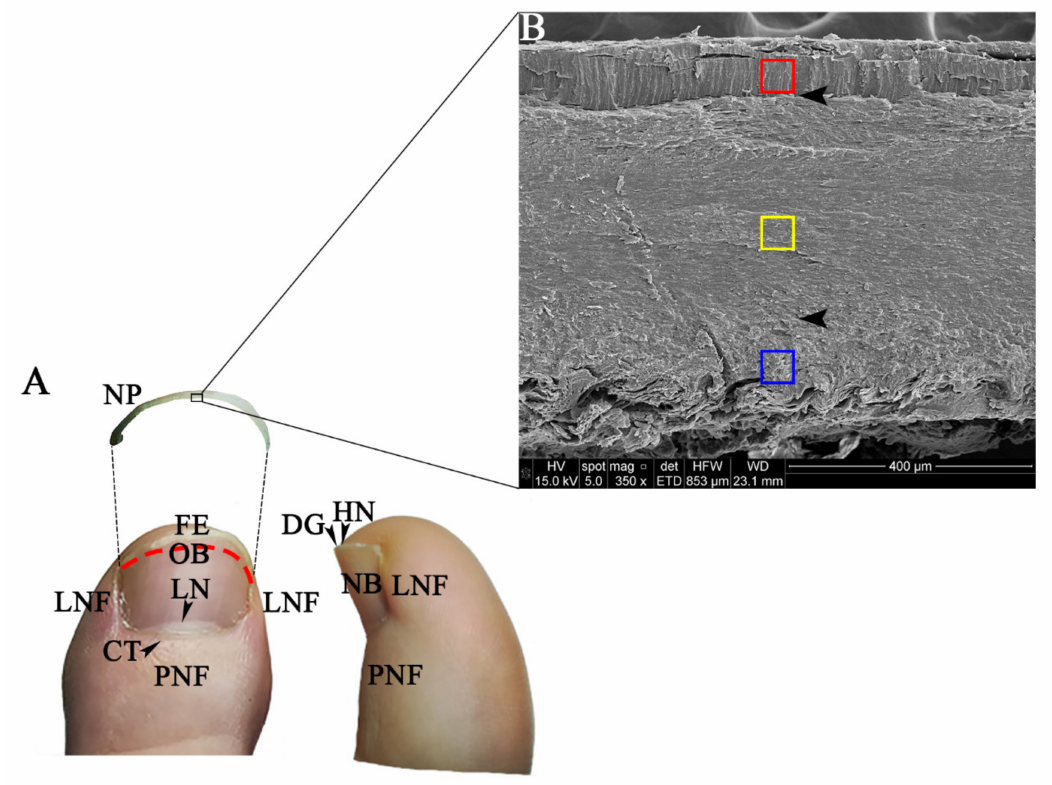
Figure 1. Nail apparatus and measuring areas in the nail plate. ( A ) Dorsal and medial view of the first toe of the left foot and elements of the nail apparatus identifiable to the naked eye. CT, cuticle; DG, distal groove; FE, free edge; HN, hyponychium; LN, lunula; LNF, lateral nail fold; NB, nail bed; NP, nail plate; OB, onychodermal band (red discontinuous line); PNF, proximal nail fold. ( B ) Scanning electron micrograph in high vacuum conditions to illustrate the structure of human nail plate and the measuring areas selected. The dorsal area (red), intermediate area (yellow), and ventral area (blue) layers are shown. Arrowheads indicate the limit between the nail plate